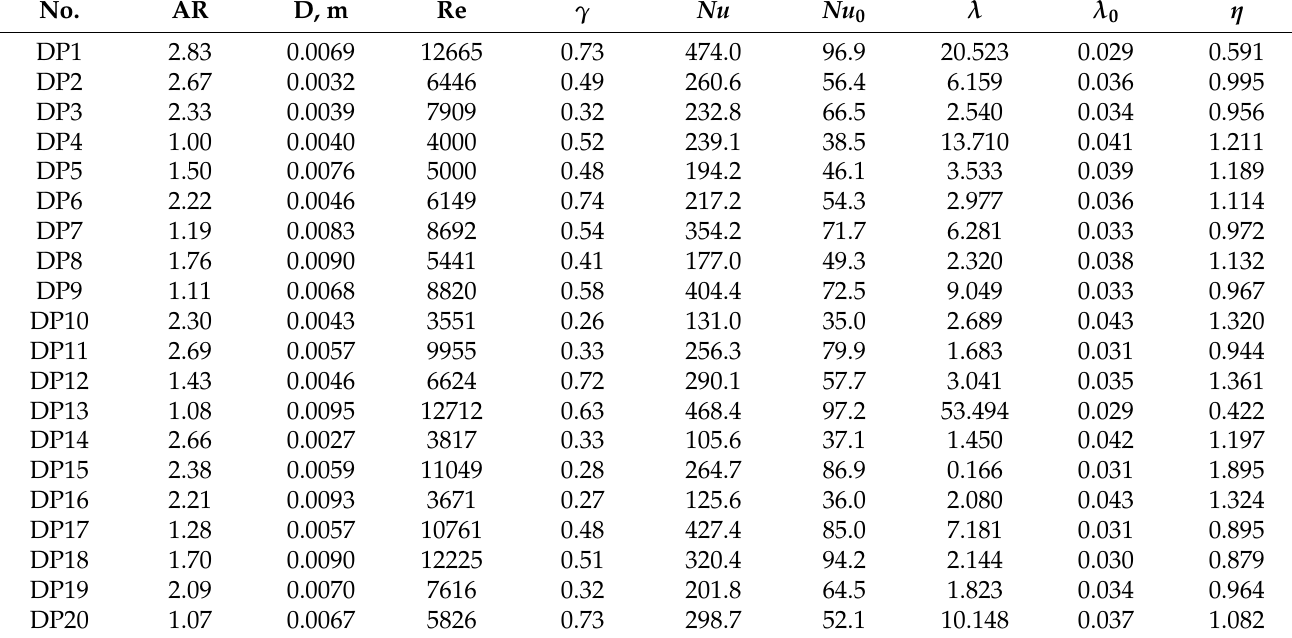
Table A1. Sample set and numerical simulation of Design Points sampled by Latin hypercube sampling.